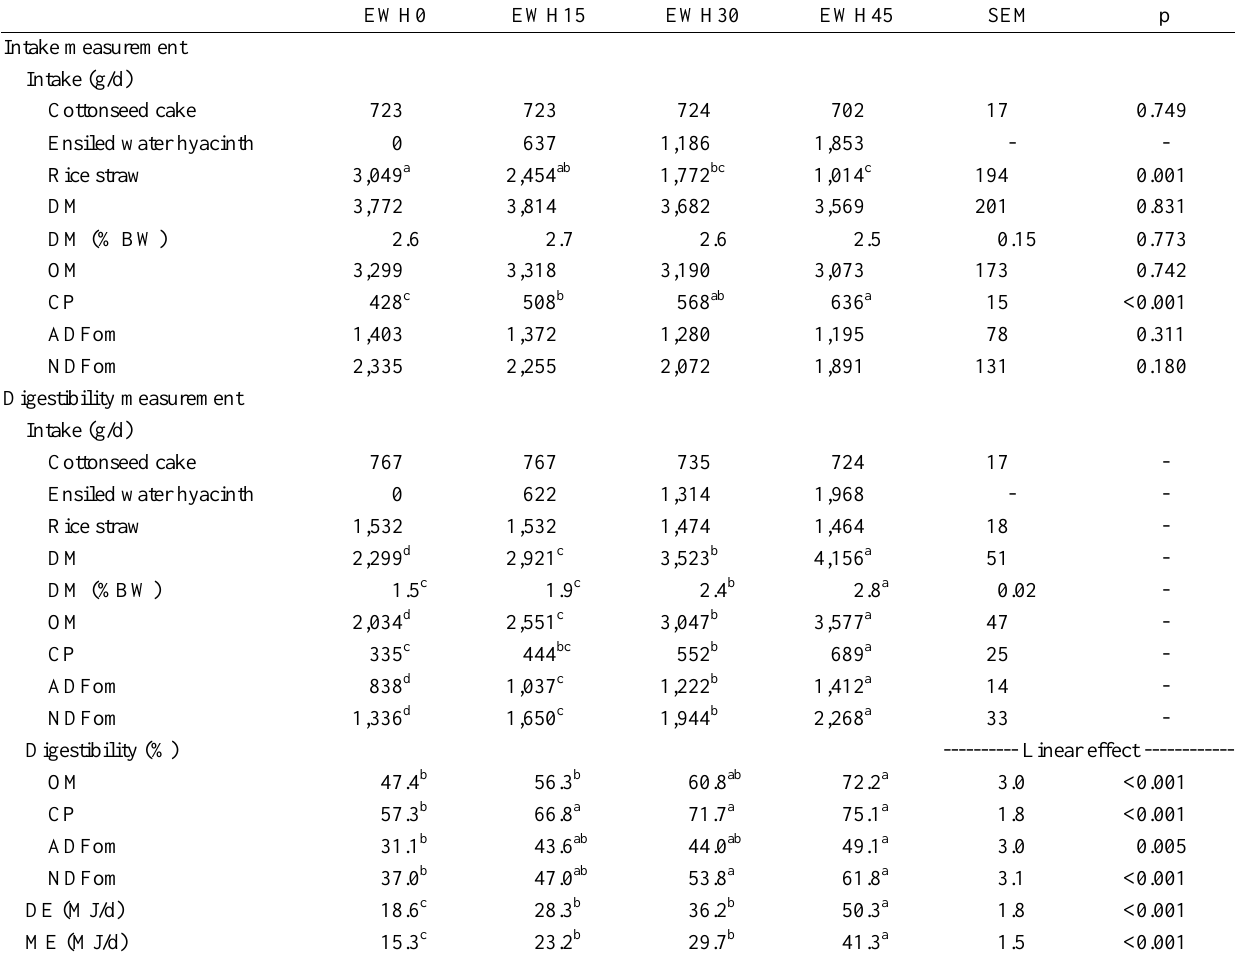
Table 3. Intake and digestibility of the diets from the intake and digestibility